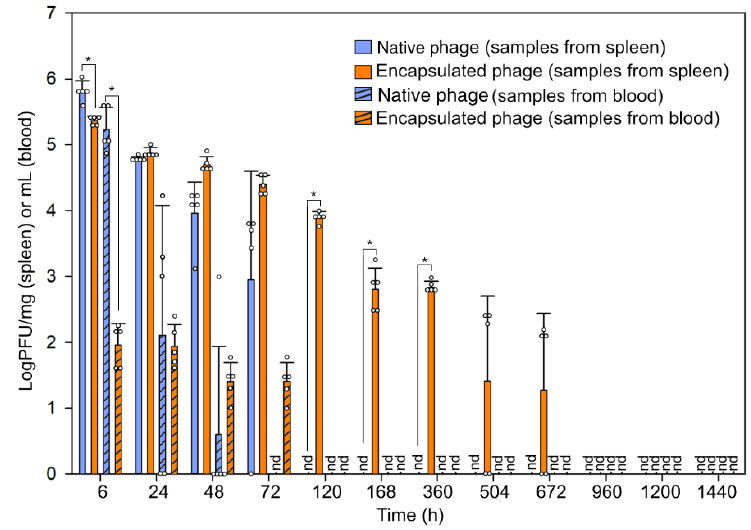
Figure 3. Fate of bacteriophages in vivo (mean ± SEM, n = 5). nd: not detected. Blue and orange represent native and polylactic-co-glycolic acid (PLGA)/alginate-encapsulated bacteriophages, re- spectively. Bars without and with stripes represent samples from spleen and blood, respectively. Asterisk (*) indicates statistical significance.